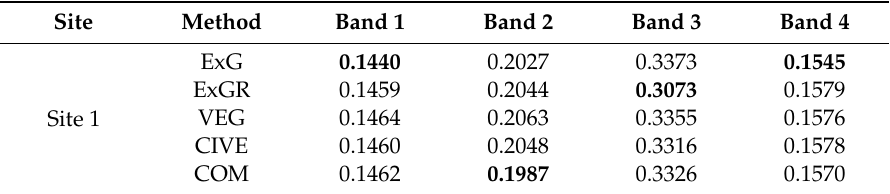
Table 4. Comparison of the NRMSE for each spectral index.